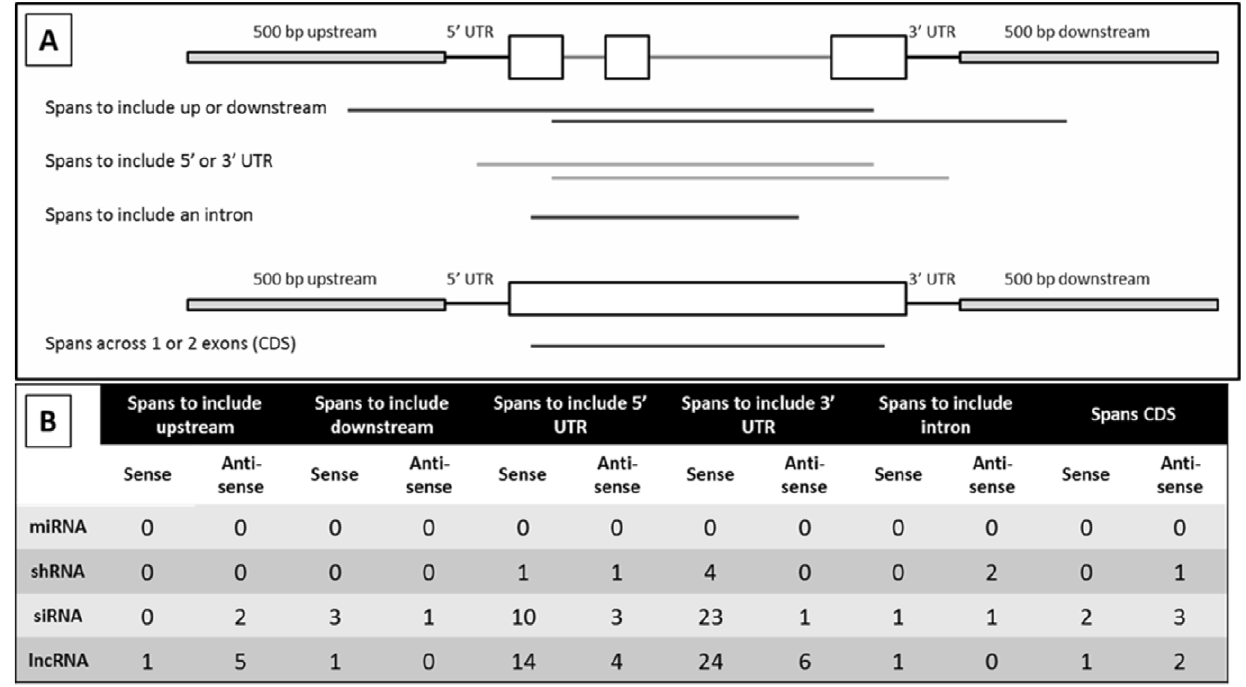
Figure 6. Results of genic localization for ncRNAs covering 50–98% of a gene model. A total of 118 ncRNAs were had homology with filtered gene set genes that covered 50–98% of the gene model. This homology spanned different genic features (A). The number of sequences that aligned with a specific genic feature is indicated for each groupof ncRNAs (B).